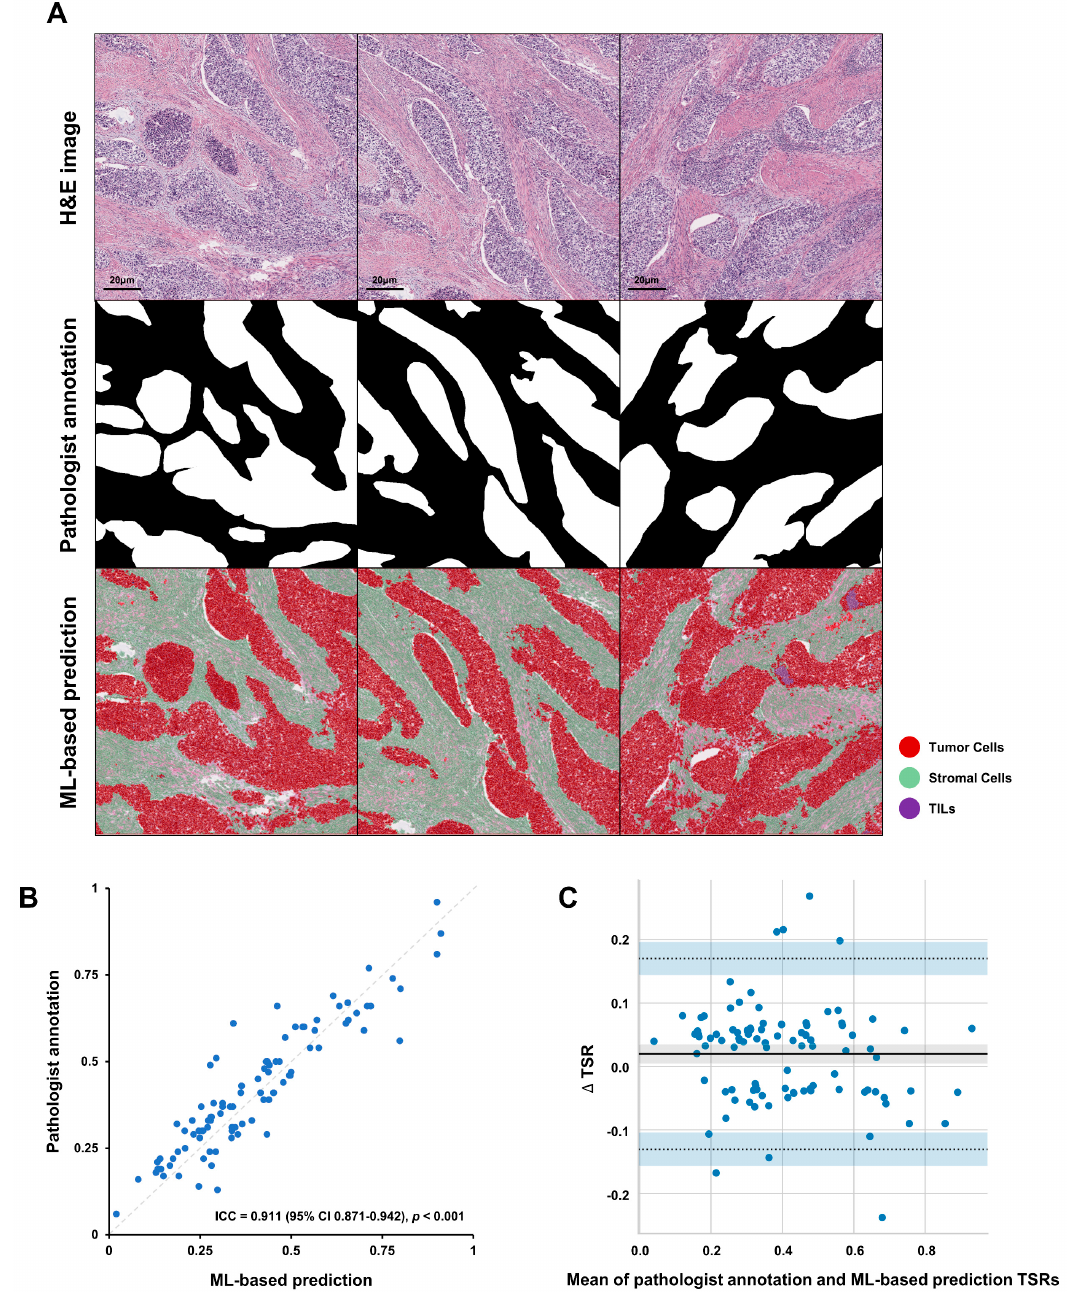
Figure 2. The results of TSR consistency analysis. ( A ) Examples of H&E images, pathologist anno- tations, and ML algorithm predictions. ( B ) Concordance between ML-based TSR and pathologist. ( C ) Bland-Altman plot for TSR estimation between ML algorithm and pathologist. The solid horizontal black line is the mean and the two dashed lines are ± SD. TSR, tumor-stromal ratio; HE, hematoxylin- and-eosin; ML, machine learning; TILs, tumor-infiltrating lymphocytes; SD, standard